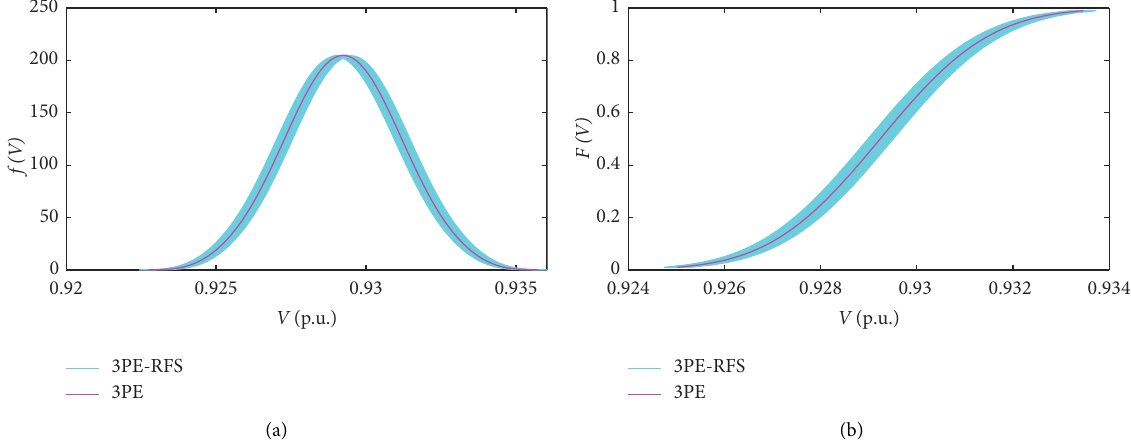
Figure 5: Te PDF and CDF images of V